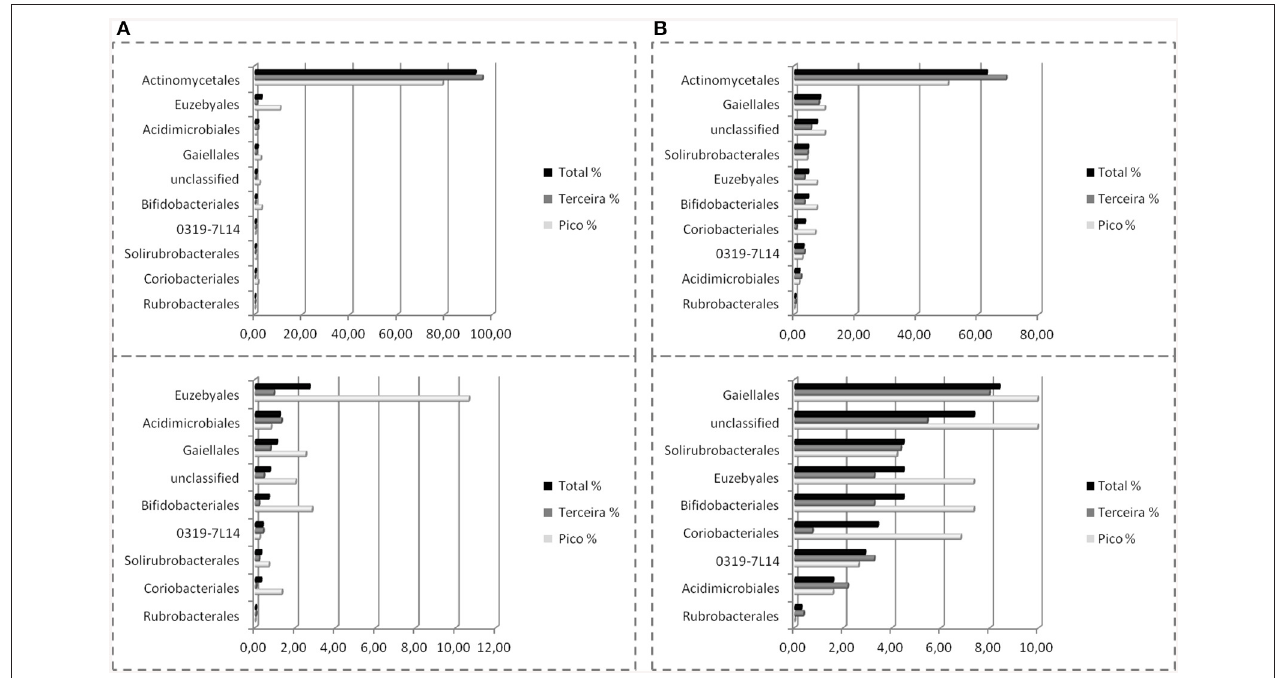
FIGURE 8 | Order-Level delineation of the 16S rRNA gene sequences (A) and OTUs (B) in Azorean volcanic caves obtained by amplicon library.